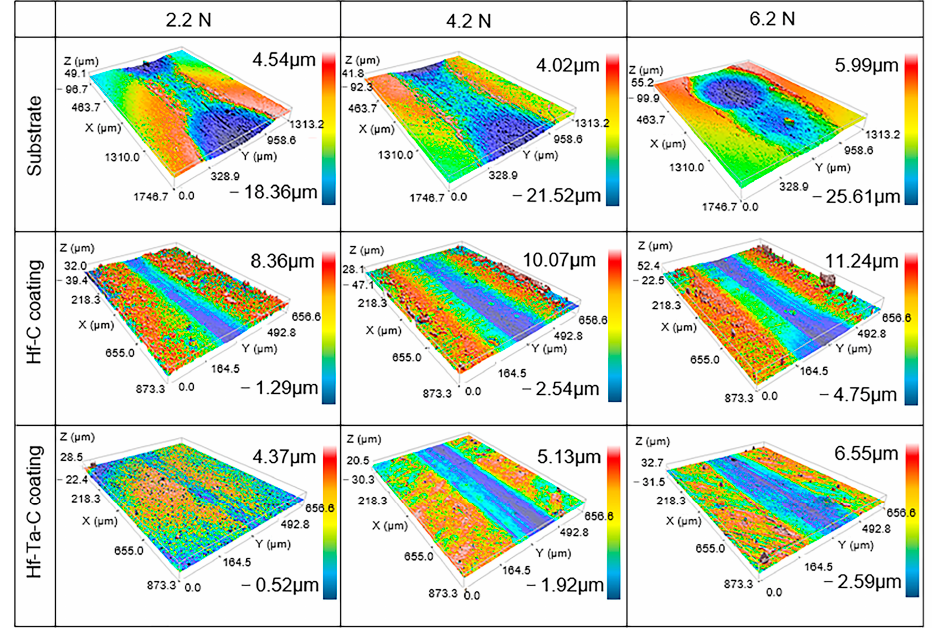
Figure 11. Three-dimensional topography of the wear scars under different load conditions at room temperature .